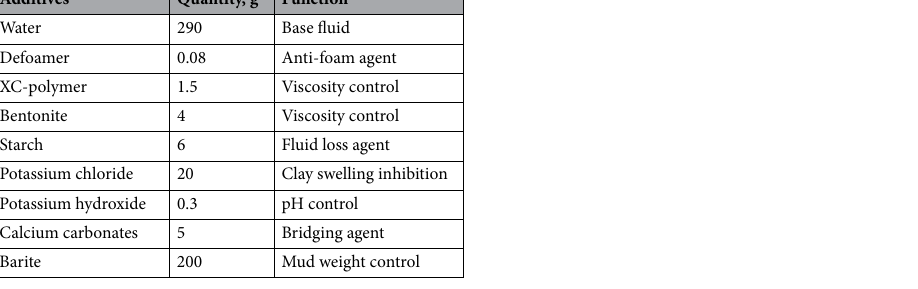
Table 1. WBM formulation for the study.